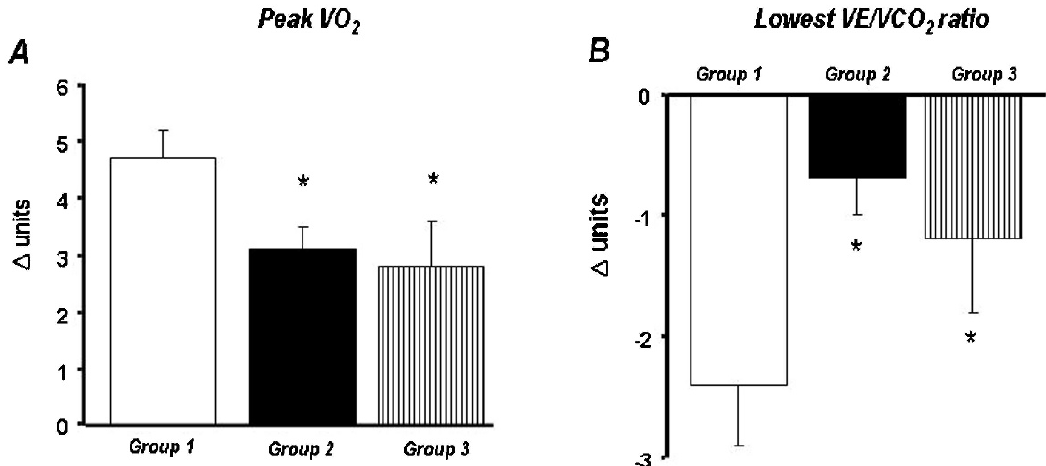
Figure 1 - Absolute changes in aerobic fitness (Panel A) and ventilatory efficiency (Panel B) in CAD patients who underwent aerobic exercise training. Peak VO 2 , peak oxygen consumption; * p , 0.05 vs . group 1.